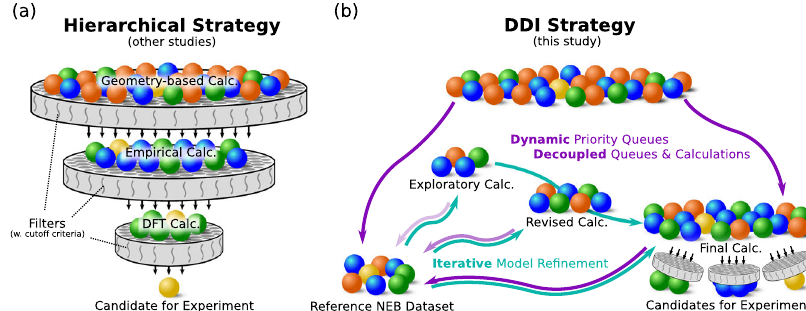
Fig. 1 Comparison of hierarchical 27 – 30 and DDI (dynamic, decoupled, and iterative) search strategies. a Hierarchical searches perform successive calculations of increasing quality and computational cost, but low-quality predictors are used to remove most candidates. This strategy is possible only when heuristics are already known, and it does not allow selection criteria to change at later stages. b The DDI strategy used in this study creates a high-quality reference dataset, which is then used to create and iteratively re fi ne rapid calculations. We used this approach to develop a rapid calculation for fl uoride mobility and to predict barrier heights for a large pool of